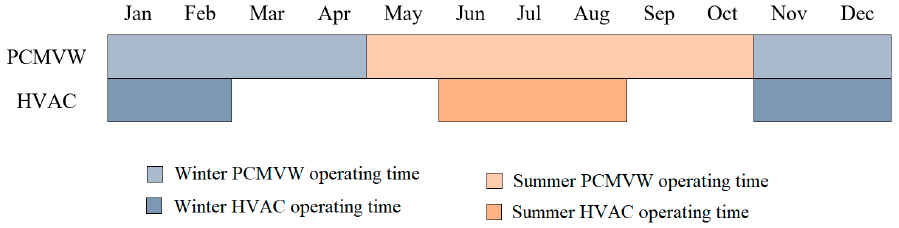
Figure 6. The PCMVW and HVAC (heat pump) operation schedule.